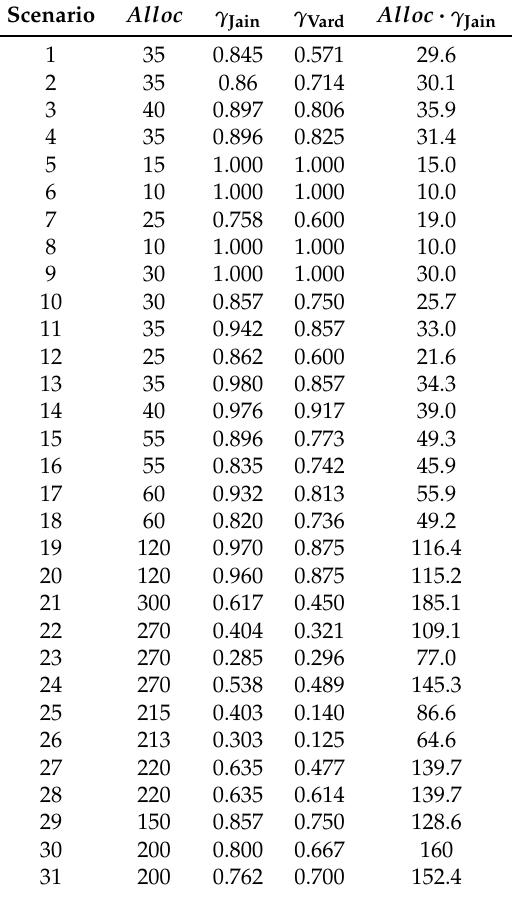
Table 13. Performance evaluation for BFF-II. Alloc values in